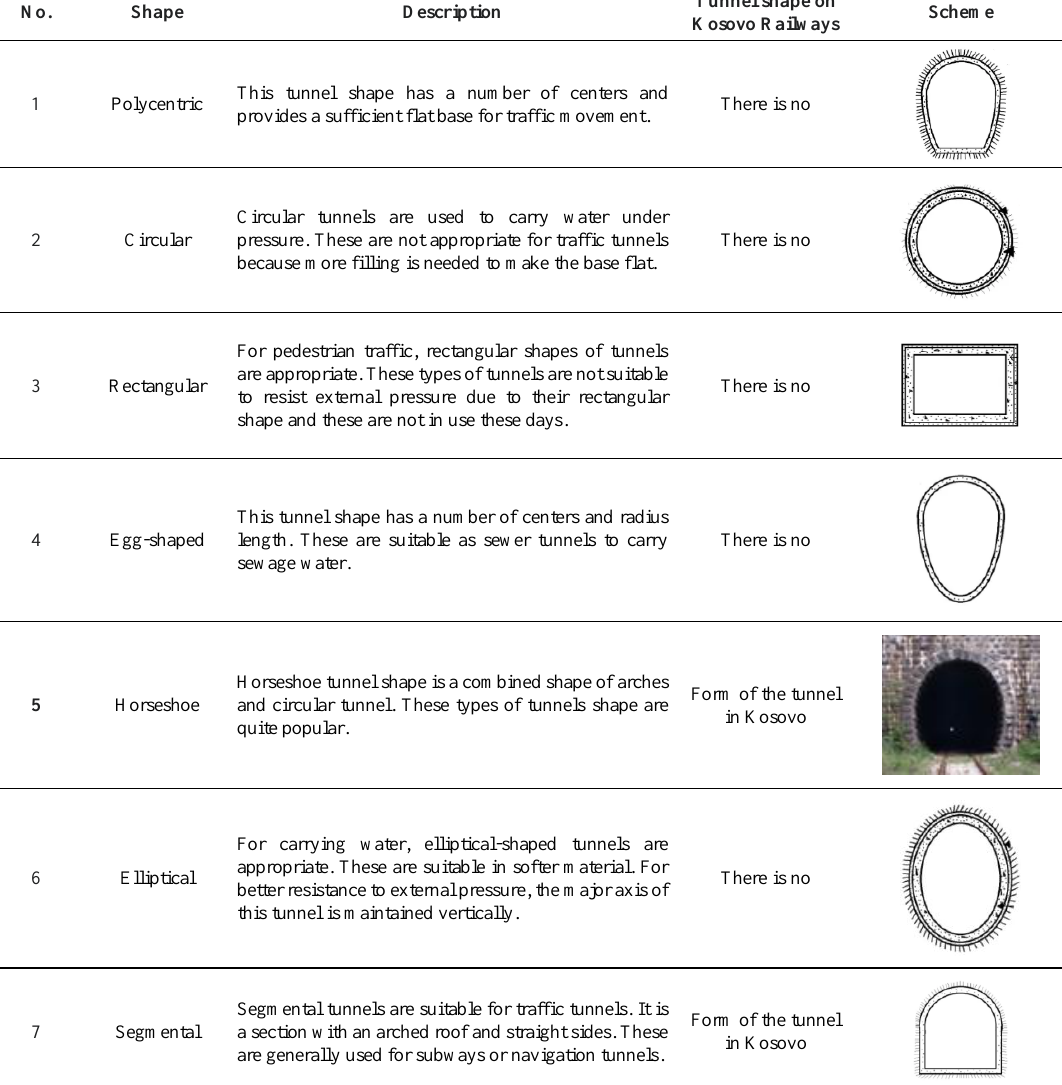
Table 8. Geometric shapes of